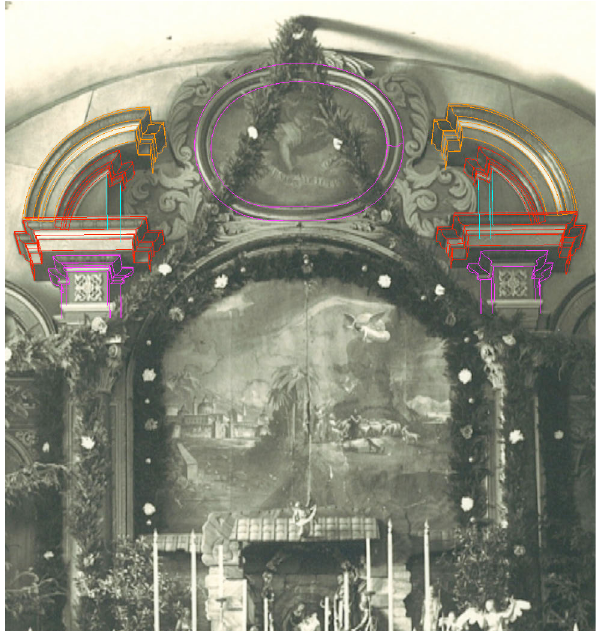
Figure 8: Rigorous audit by back projection of the reconstructed outlines into historical photo 2